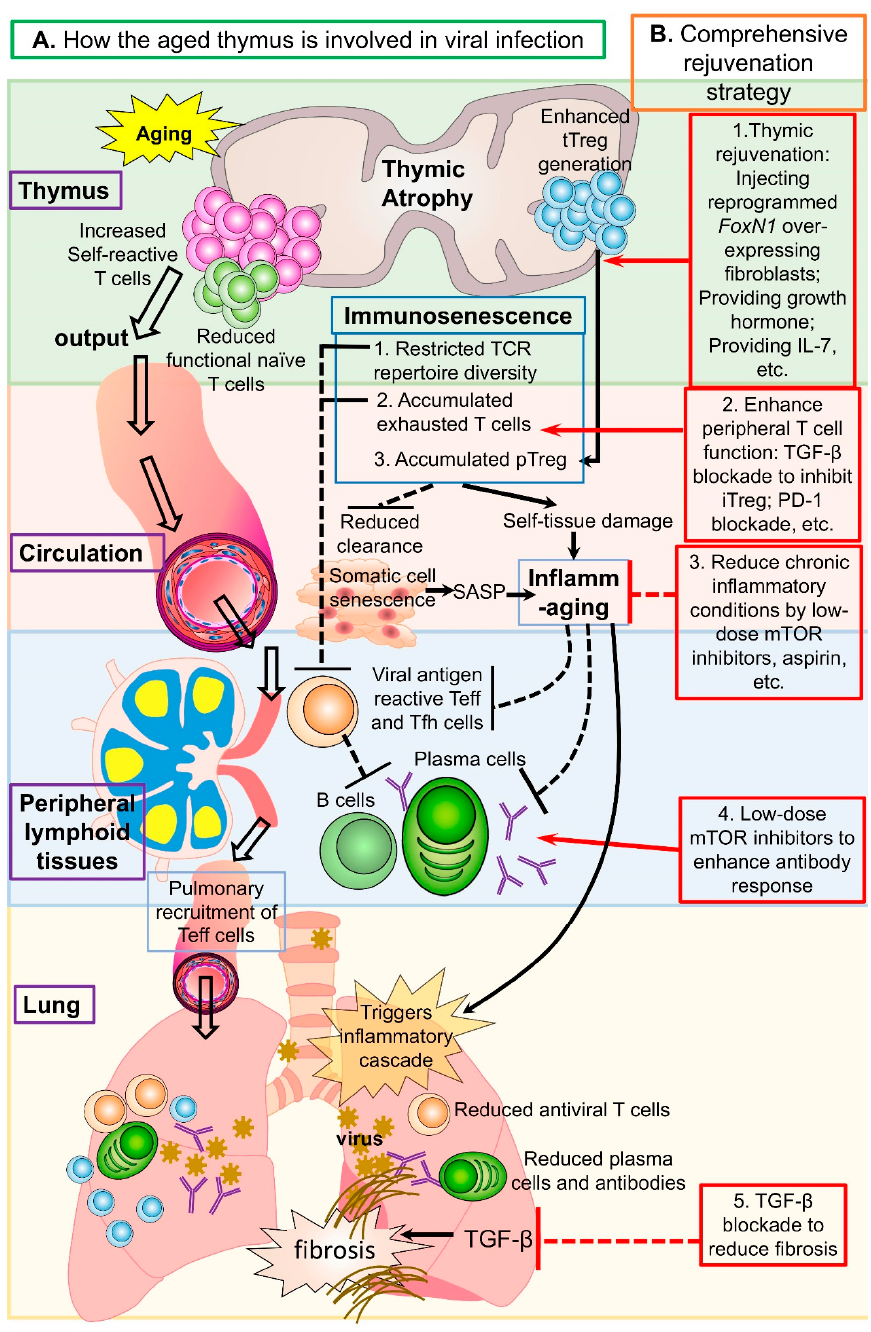
Figure 1. How the aged thymus is involved in viral infection and a proposed comprehensive rejuvenation strategy for enhanced antiviral immunity and vaccination efficiency. ( A ) Left panels show the T cell pathway from the thymus to the lung during respiratory viral infection, such as SARS-CoV-2, using arrows. Middle panels show how immunosenescence and inflammaging are detrimental to antiviral immunity. ( B ) Right panels (red boxes) are proposed rejuvenation checkpoints where the dotted red lines are inhibition or blockade and the solid red lines with arrows are promotion or